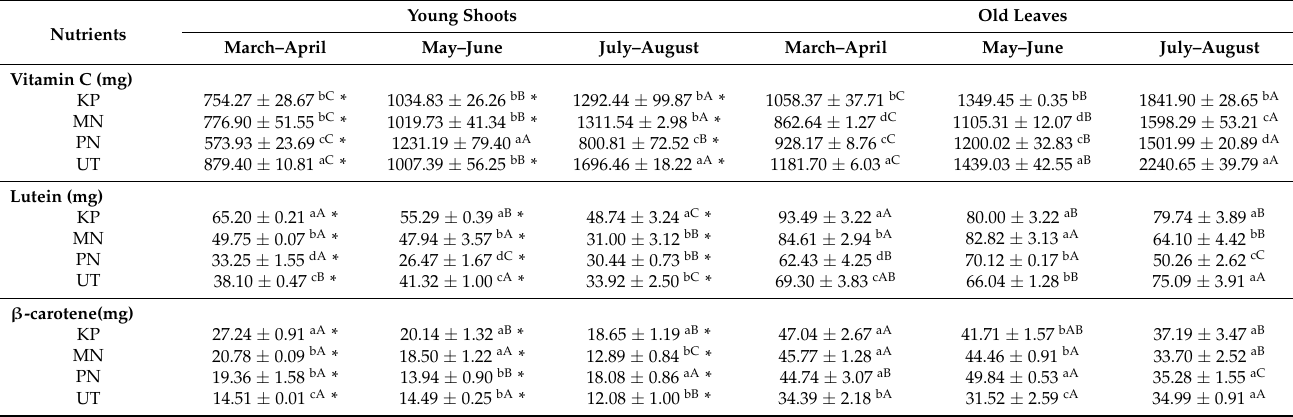
Table 4. Vitamin C and carotenoid (lutein and β -carotene) contents (per 100 g dry weight) in young shoots and old leaves of Adenia viridiflora Craib. from different origins including Kamphaeng Phet (KP), Muang Nakhon Ratchasima (MN), Pakchong Nakhon Ratchasima (PN), and Uthai Thani (UT) collected in different harvesting periods. Young Shoots Old Nutrients